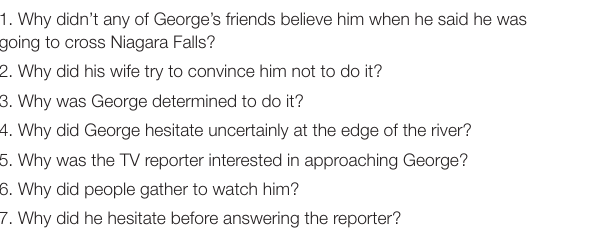
TABLE 2 | Inference questions.